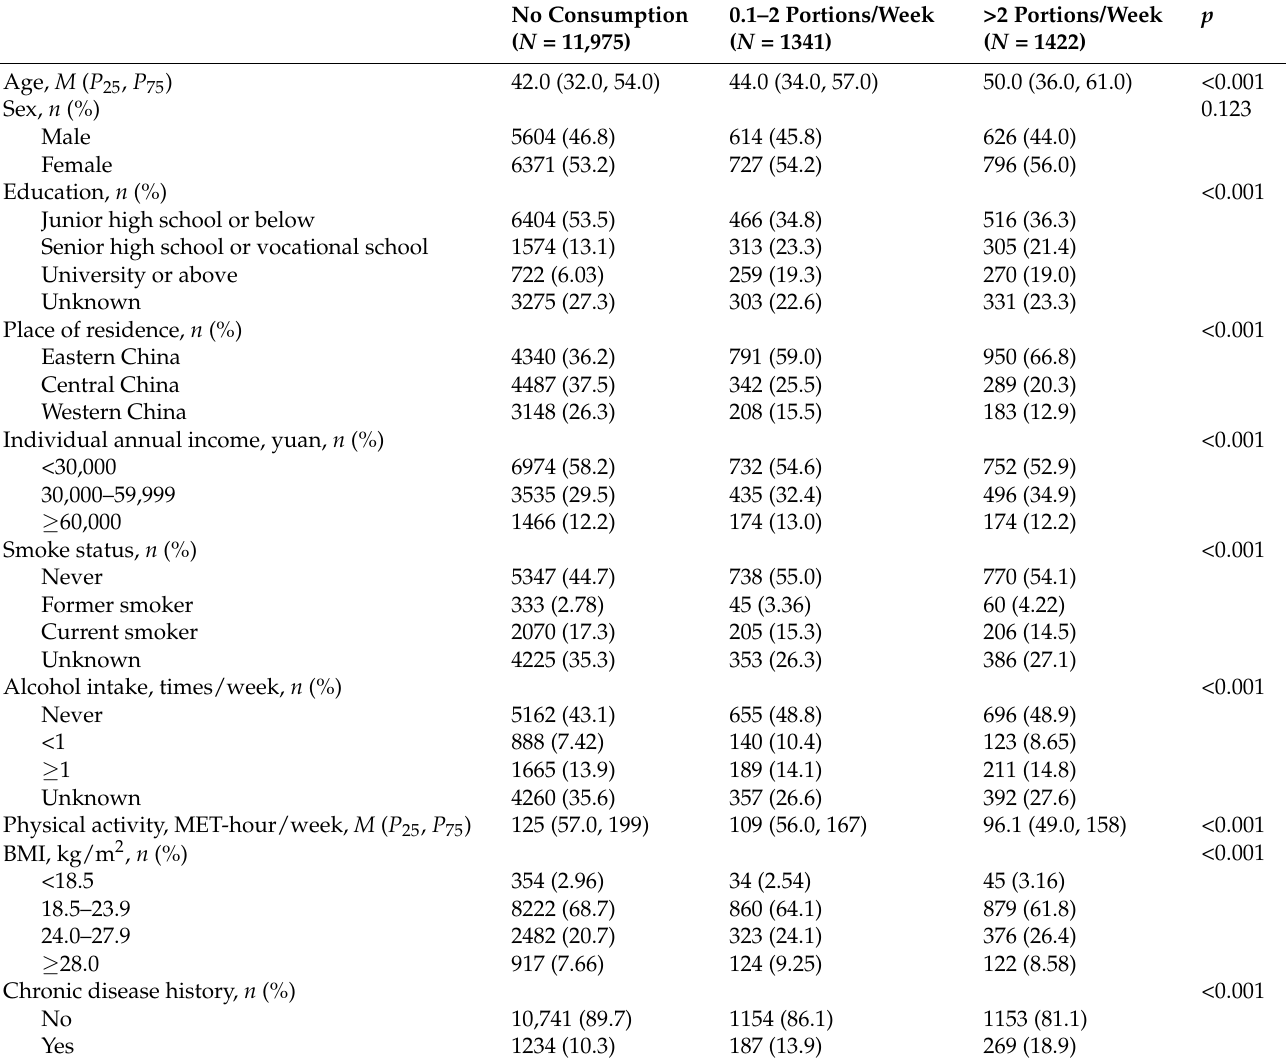
Table 1. Baseline sociodemographic and behavioral characteristics of